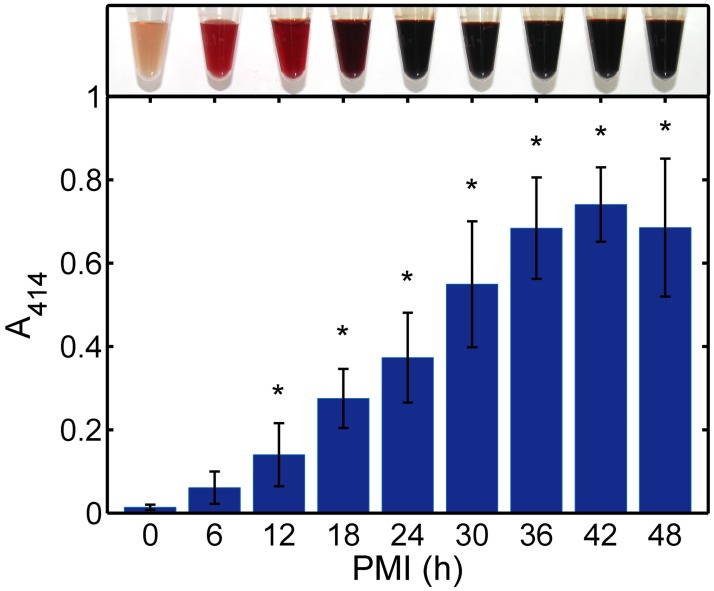
Plasma color inspection and the A414 values.A typical change in plasma color was compared with the average absorbance measured at 414 nm and the standard deviations. *P < 0.05 indicates a significant difference from the 0-h group.